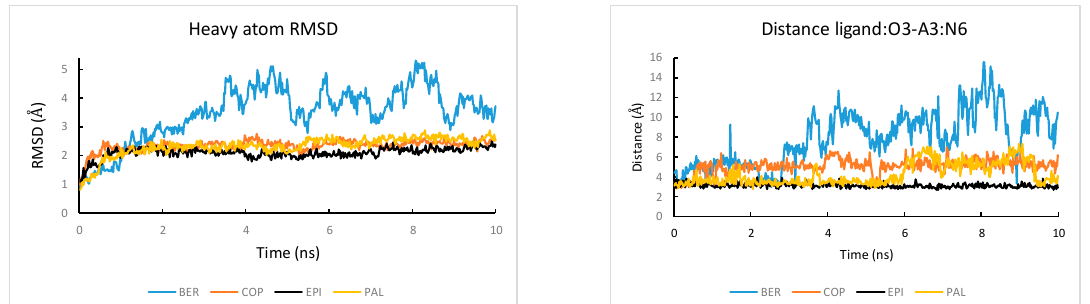
Figure 7. The MD simulated time courses of ( left ) the RMS deviation from the starting structures of the complex and ( right ) the ligand:O3 ‐ A3:N6 distance in the complexes of the four ligands bound to the wtTel26 G4.